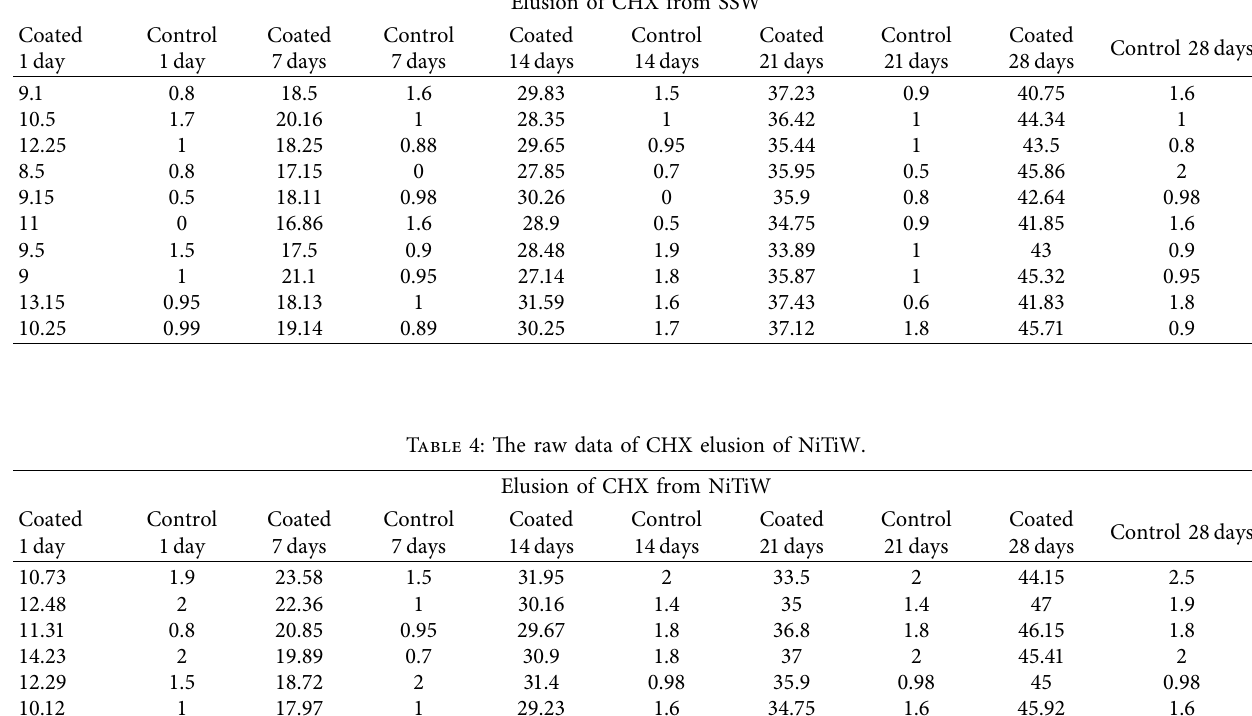
Table 3: Te raw data of CHX elusion of SSW. Elusion of CHX from SSW